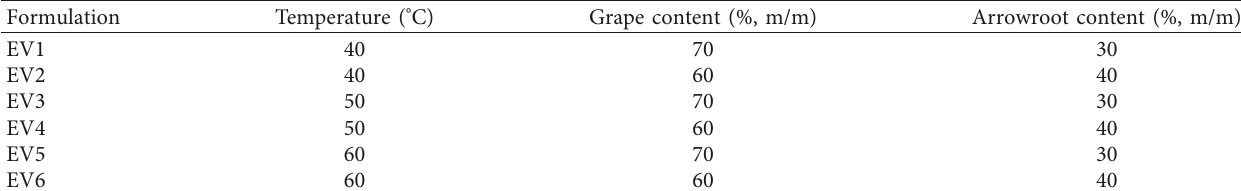
Table 1: Conditions of the drying processes used to obtain powdered antioxidant compounds.